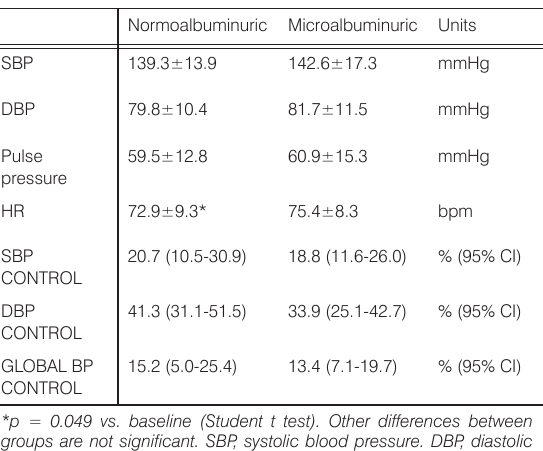
Table 3. Blood pressure after treatment